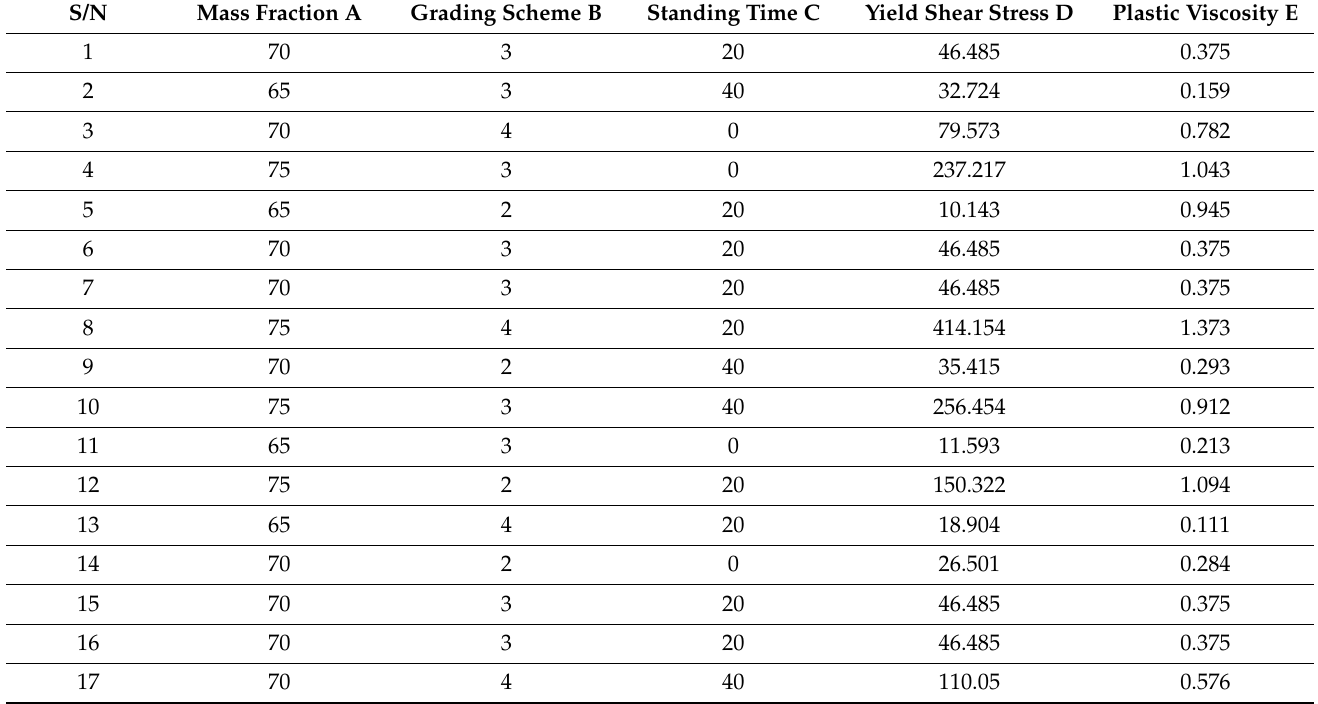
Table 8. Test scheme and results.